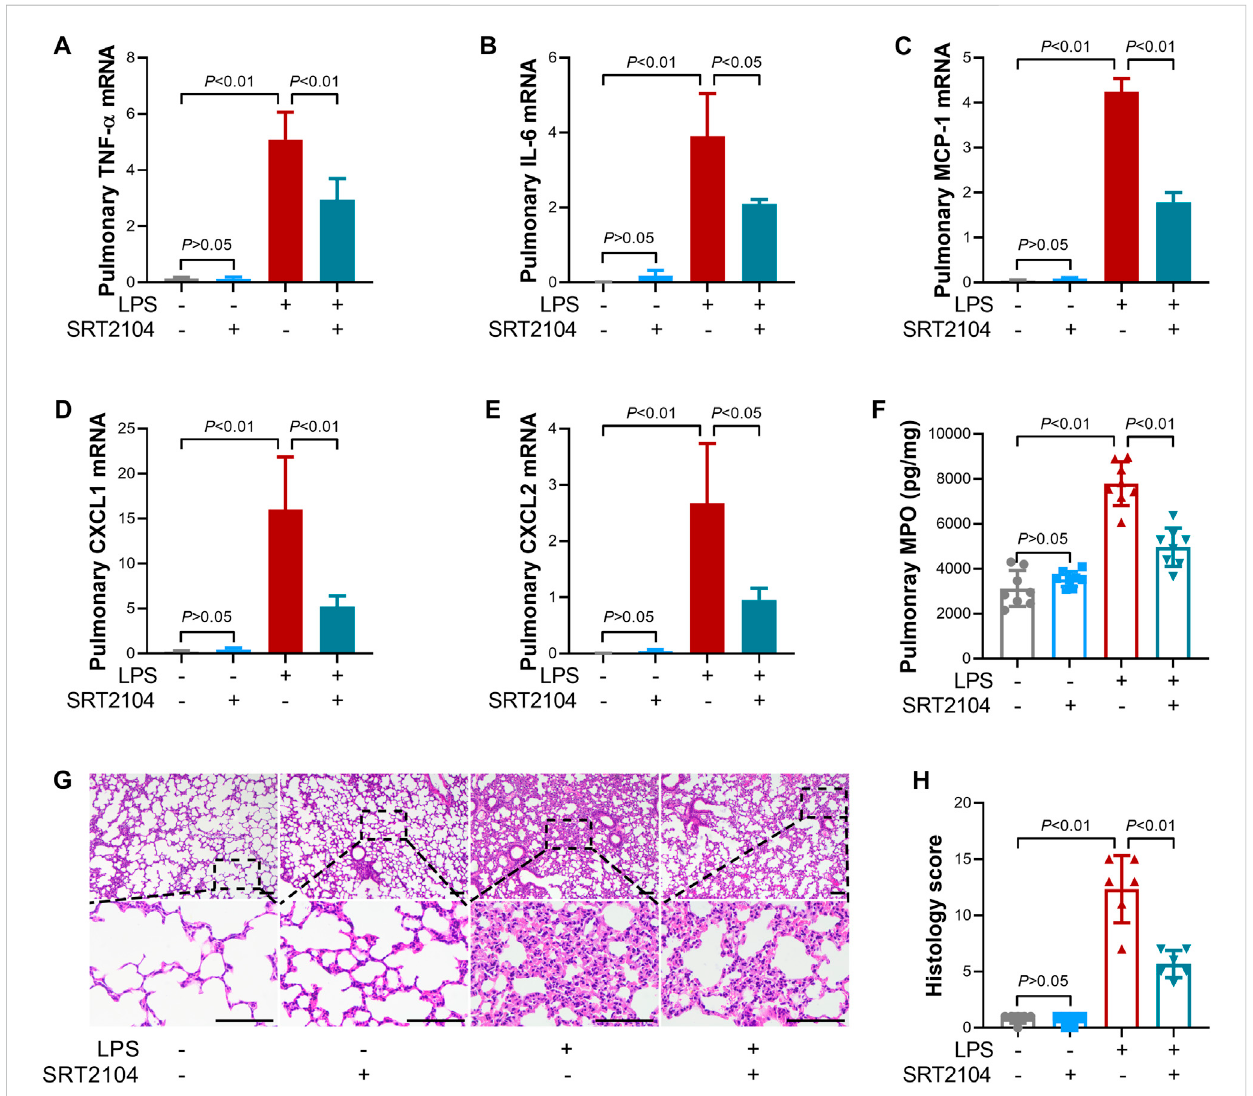
FIGURE 2 SRT2104 suppressed LPS-induced in fl ammatory lung injury. C57BL/6 mice were challenged with LPS to induce systemic in fl ammation, vehicle or SRT2104(25 mg/kg)wasadministeredintraperitoneally.Themiceweresacri fi ced8 hpostLPSexposure,andthelungsampleswerecollected. (A – E) The mRNA levels of (A) TNF- α , (B) IL-6, (C) MCP-1, (D) CXCL1, (E) CXCL2 in lung tissues were determined, n = 3. (F) The level of MPO in lung tissue was determined, n = 8. (G) HE staining were performed in lung tissues and the representative image of each group was shown (Scale bar: 100 μ m);